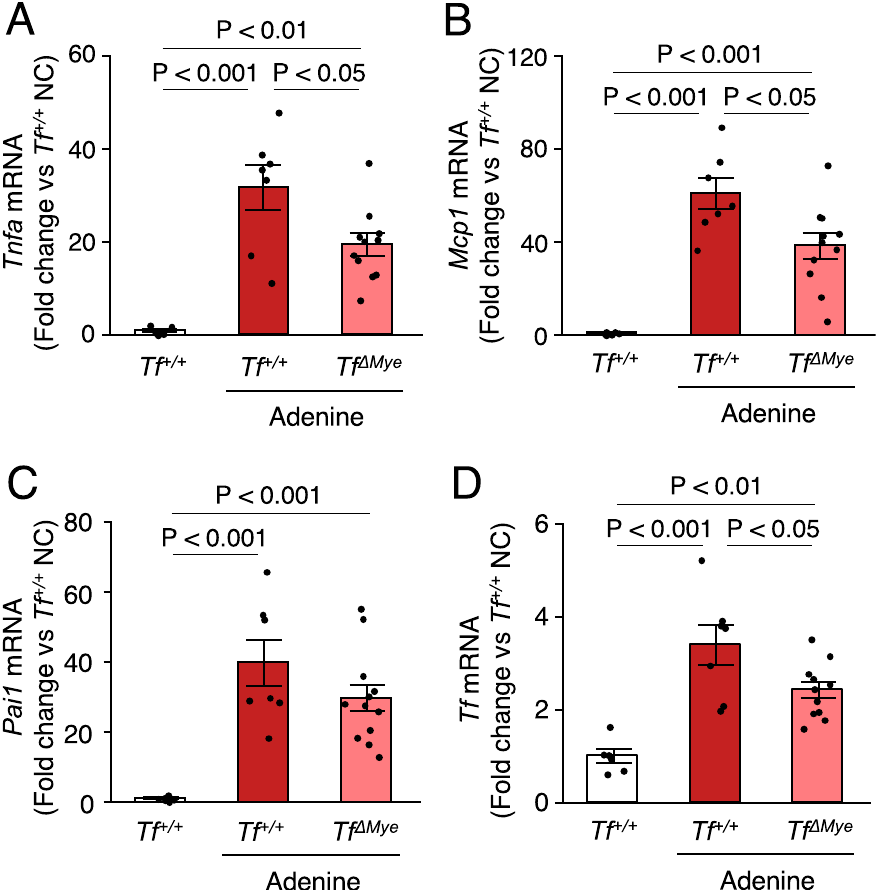
Figure 6. Myeloid TF deficiency reduces pro-inflammatory gene expression in adenine-induced tubular injury. ( A–D ) Comparison of Tnfα , Ccl2 , Pai1 , and Tf mRNA levels among groups. Data are shown as fold- change compared with Tf + / + mice fed normal chow (NC). A.U., arbitrary unit. n = 7–12. Data are shown as the mean ±